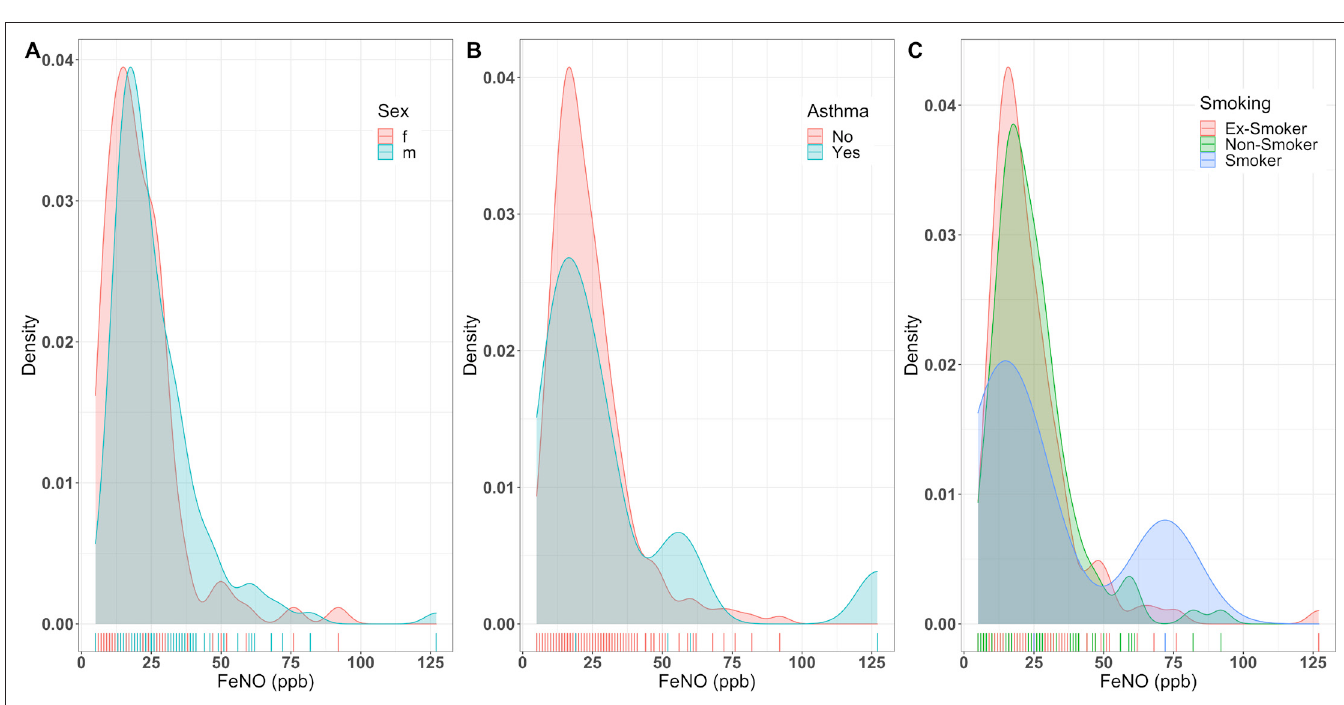
Figure 1 FeNO distribution according to clinical characteristics: A) distribution of FeNO stratified by sex; B) distribution of FeNO stratified by presence of asthma; and C) distribution of FeNO stratified by smoking status. f = female. FeNO = fractional exhaled nitric oxide. m = male. ppb = parts per